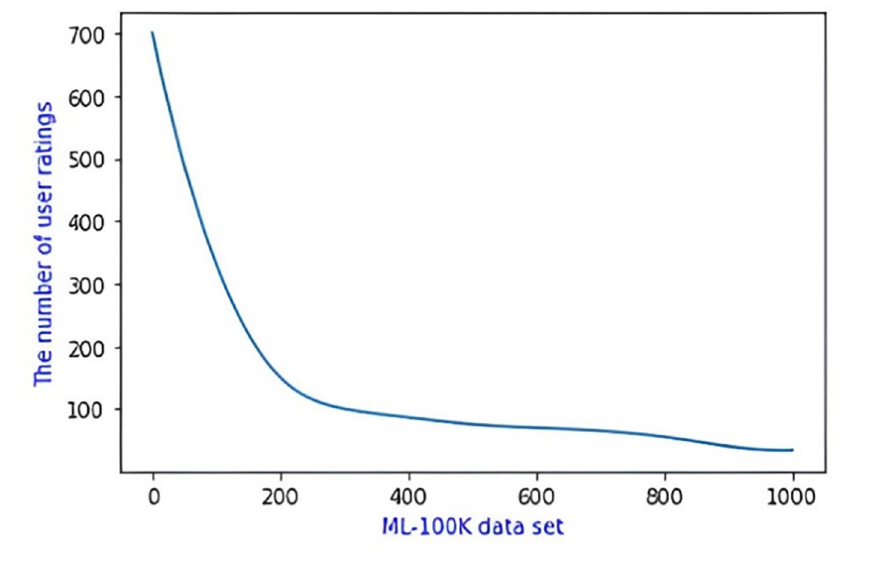
Fig 3. ML-100K data